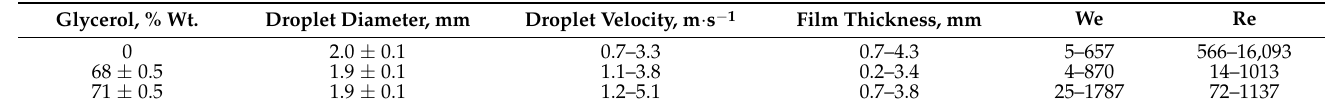
Table 2. Conditions of the film rupture experiments. Weber number, We, and Reynolds number, Re, were calculated by using film thickness as a characteristic length.